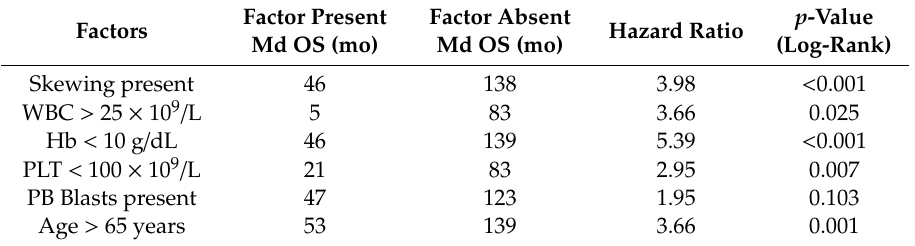
Table 2. Univariate analysis of single prognostic parameters in patients with myelofibrosis. p -Value Factor Present Factor Absent Hazard Ratio Factors (Log-Rank) Md OS (mo) Md OS (mo) Skewing present 46 138 3.98 < 0.001 WBC > 25 × 10 9 / L 5 83 3.66 0.025 Hb < 10 g / dL 46 139 5.39 < 0.001 PLT < 100 × 10 9 / L 21 83 2.95 0.007 PB Blasts present 47 123 1.95 0.103 Age > 65 years 53 139 3.66